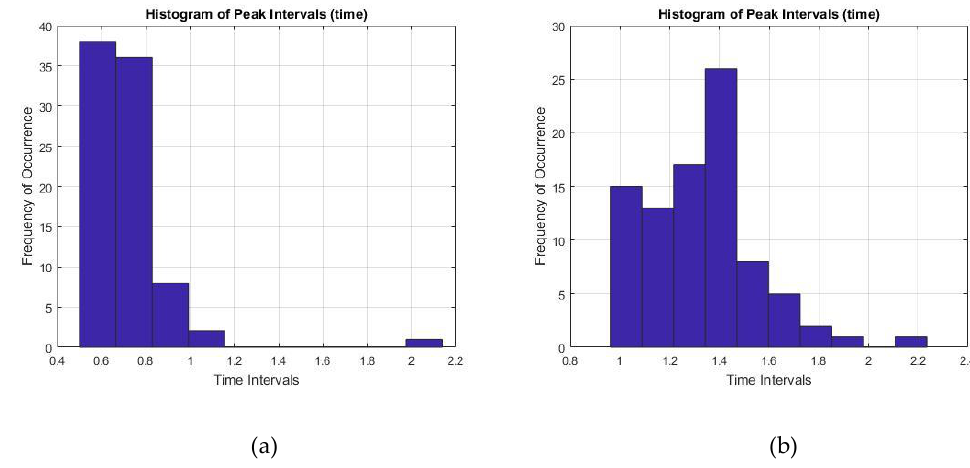
Figure 12. Histogram of RR peak intervals for ( a ) healthy ECG data and ( b ) AF ECG data.